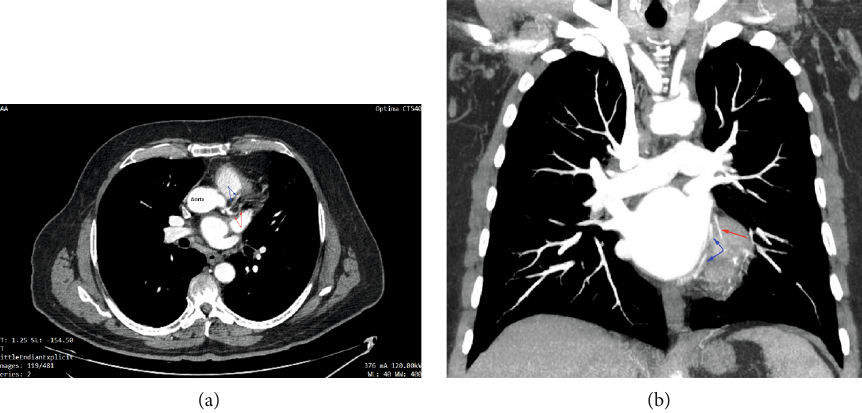
Figure 5: CT angiography of the aorta revealing a short LMCA (a) which then splits into two distinct branches (pointed with arrows of di ff erent color) descending toward the apex in the anterior interventricular groove. The short LAD is pointed with blue arrows and the long LAD with red